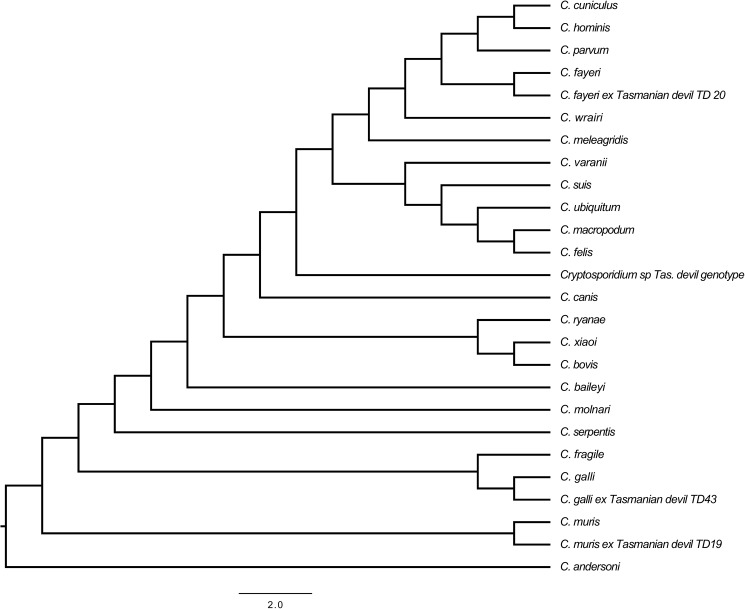
Inferred phylogeny of Cryptosporidium 18S rDNA consensus sequences (709 nucleotides).The Cryptosporidium 18S rDNA reference sequences used for this phylogeny are as follows: C. andersoni (FJ463171), C. baileyi (L19068), C. bovis (AY741305), C. canis (AF112576), C. cuniculus (FJ262765), C. fayeri (AF108860), C. felis (AF108862), C. fragile (EU162751), C. galli (HM116388), C. hominis (AF093491), C. macropodum (AF513227), C. meleagridis (AF112574), C. molnari (HM243548), C. muris (AF093497), C. parvum (AF108864), C. ryanae (FJ463193), C. serpentis (AF151376), C. suis (AF108861), C. ubiquitum (AF442484), C. varanii (AF112573), C. wrairi (AF115378), C. xiaoi (FJ896053).